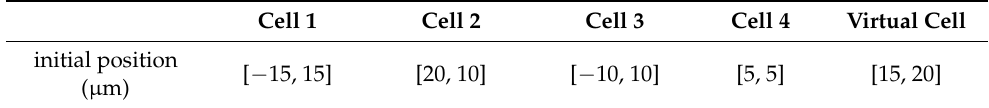
Table 3. Initial position of each yeast